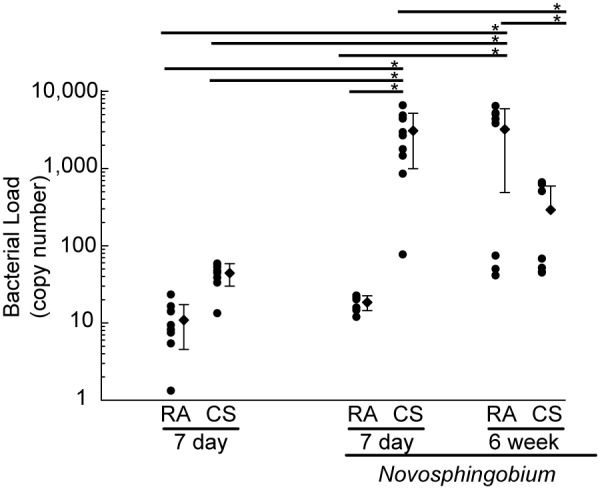
Evaluation of the presence and levels of total bacteria by qPCR on BAL.BAL samples were harvested from mice, seven days or six weeks post IT challenge with either sterile PBS or with 5×107 CFU total of Novosphingobium panipatense. BAL was analyzed by an all-bacteria qPCR. (One-way ANOVA test, significant at *p<0.05).